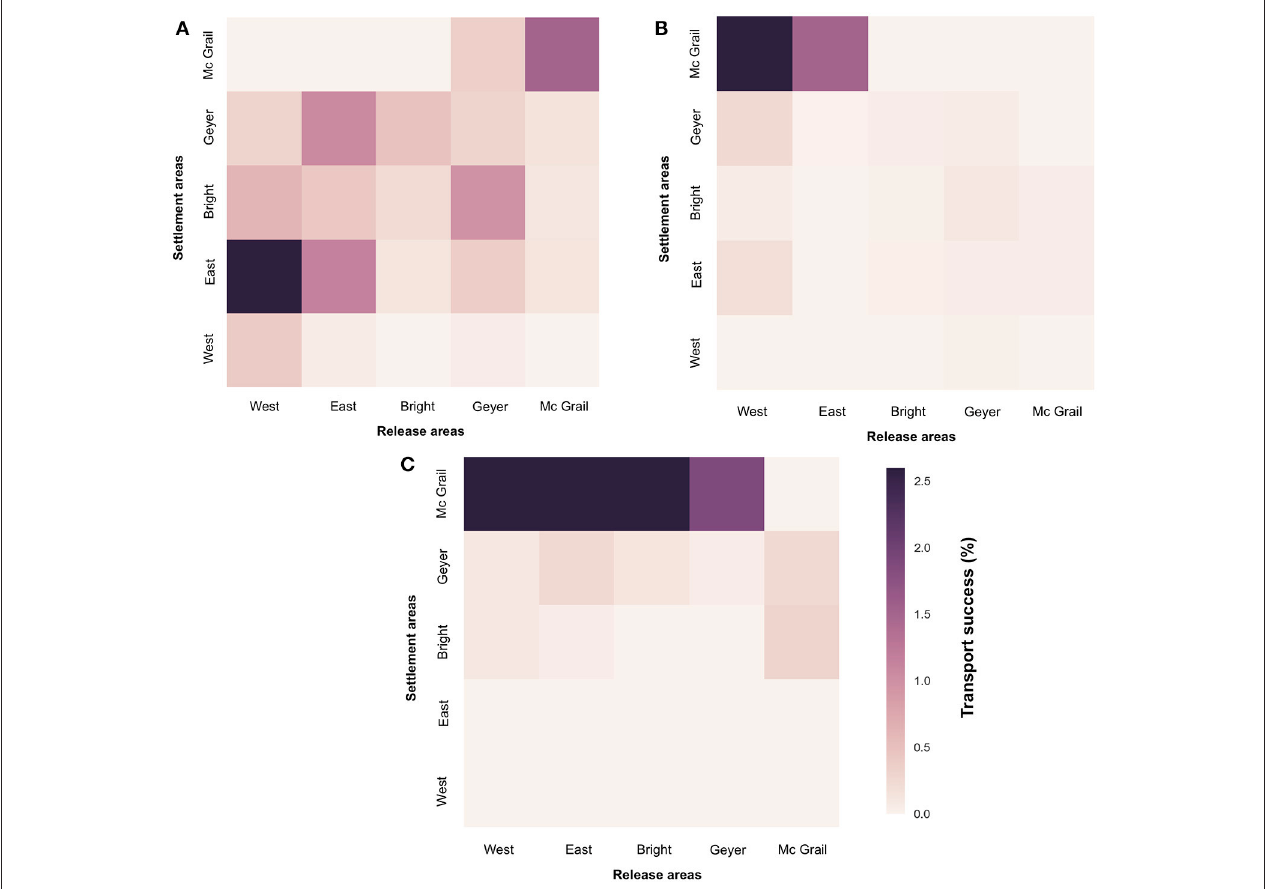
FIGURE 4 | Connectivity matrices representing the percentage of transport success of M. cavernosa larvae from release to settlement areas in the banks (West FGB, East FGB, Bright, Geyer, Mc Grail) for the years 2013 (A) , 2014 (B) , 2015 (C)